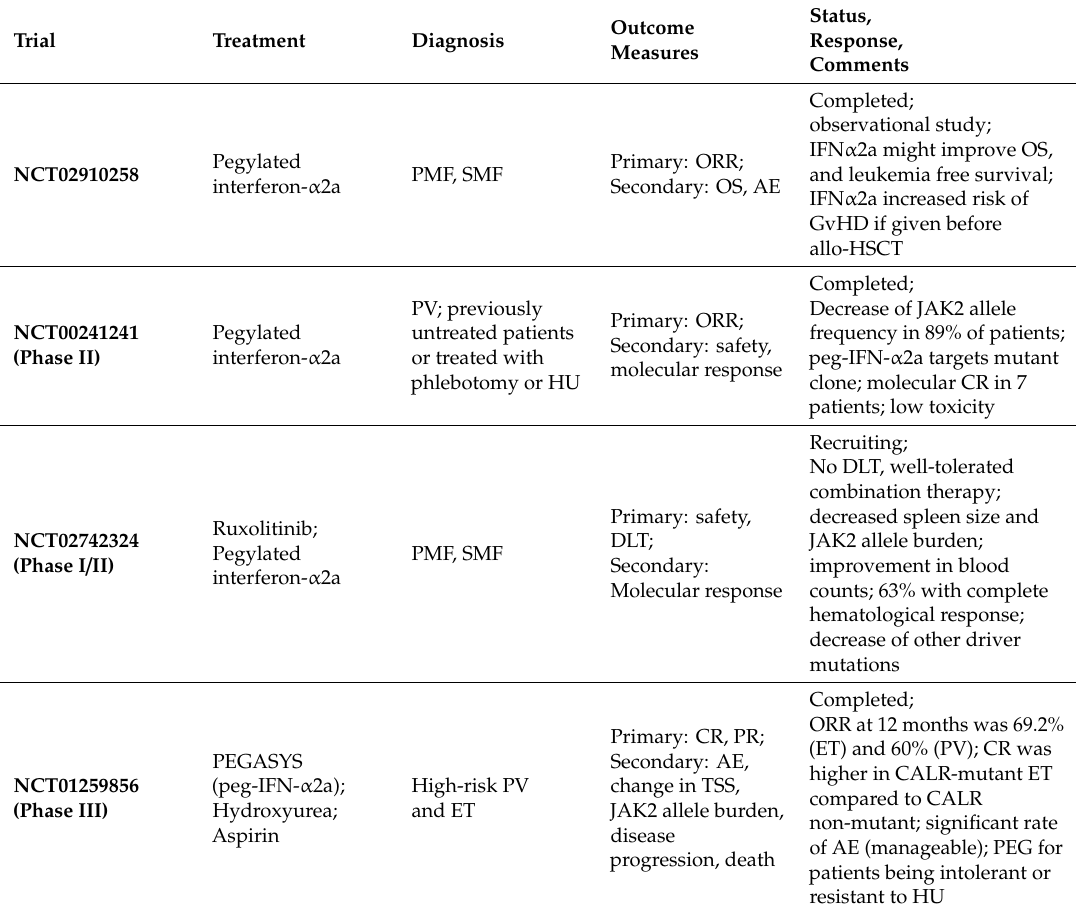
Table 1. Selected Clinical Trials of IFN- α 2a therapy in